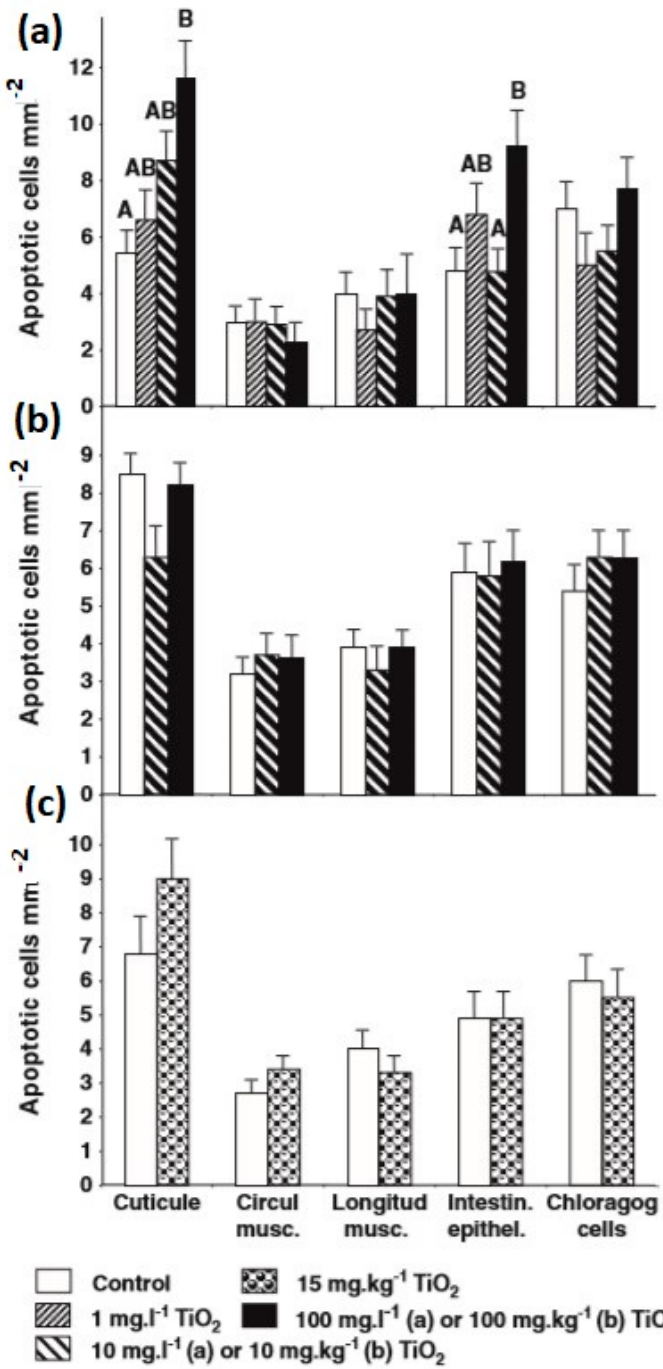
Figure 9. Apostain-positive cell mean densities of various tissues of Lumbricus terrestris earthworm exposed to: ( a ) 0.0, 1.0, 10.0. and 100.0 mg/L of titanium dioxide nanocomposites in water for seven days; ( b ) 0.0, 10.0. and 100.0 mg/kg of titanium dioxide nanocomposites in a single food batch eight weeks prior to examination; and ( c ) 0.0 and 15.0 mg/kg of titanium dioxide nanocomposites in soil for four weeks. Error bars signify the standard error of the mean. Within each tissue type, bars having same letters are not substantially different. Reproduced with permission from [184]. Elsevier, 2011